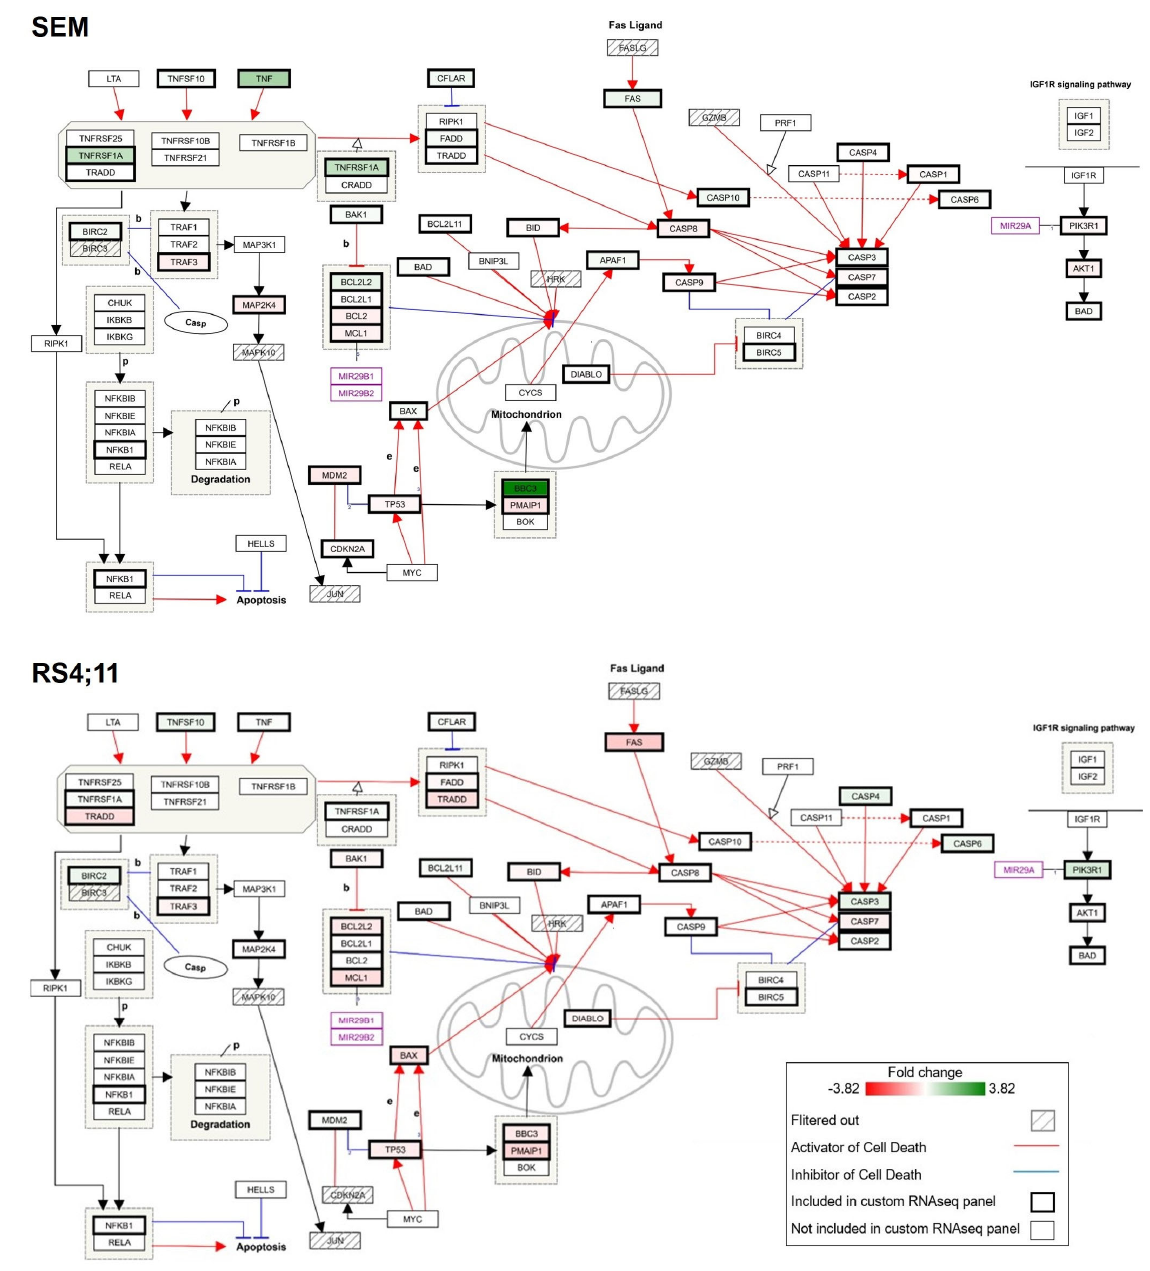
Figure 5. Effects of PERI administration on gene expression of the apoptosis signaling cascade. After 24 h of inhibitor incubation, gene expression was examined via targeted RNA sequencing. Subsequent data analysis was performed using TAC software. The WikiPathways plugin was used to integrate the FC expression values within the apoptosis signaling cascade. Green and red colors represent up- and downregulation, respectively. Genes with an average total read count < 50 were excluded to justify biological significance (labeled as filtered out).